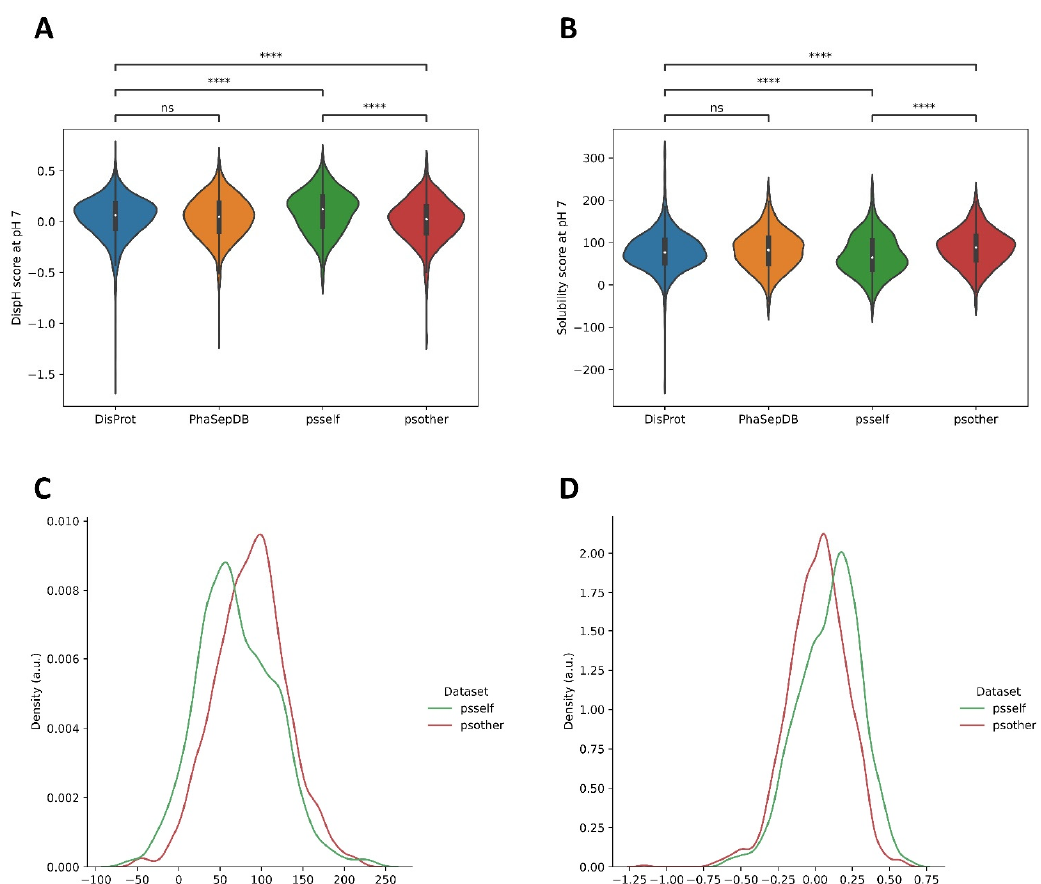
Figure 4. Comparison between solubility ( A ) and disorder ( B ) scores of DisProt, PhaSepDB, psself, and psother datasets at pH 7.0. Differences in disorder and solubility are non-significant between DisProt and PhaSepDB. However, when psself and psother are treated independently, major differ- ences can be observed with DisProt and among these sub-sets. The psself dataset exhibits lower solubilities ( C ) and lower disorder ( D ) than psother sequences *. The density coordinate provides a representation of the number of observed sequences for each given score. * ( A ) Solubility: DisProt– psself (2.321 × 10 − 05 ); DisProt–psother (2.000 × 10 − 07 ); psself-psother (2.744 × 10 − 12 ). * ( B ) Disorder: DisProt–psself (3.282 × 10 − 07 ); DisProt–psother (2.902 × 10 − 05 ); psself-psother (4.457 × 10 − 13 ). Four asterisks (****) indicate p ≤ 0.0001. “ns” indicate p > 0.05. When the differences between maximum and minimum solubility and disorder scores were analyzed in the entire selected pH range (from pH 4.0 to pH 9.0 with a step size of 0.1, as detailed in the Methods section), DisProt exhibited the broader dispersion